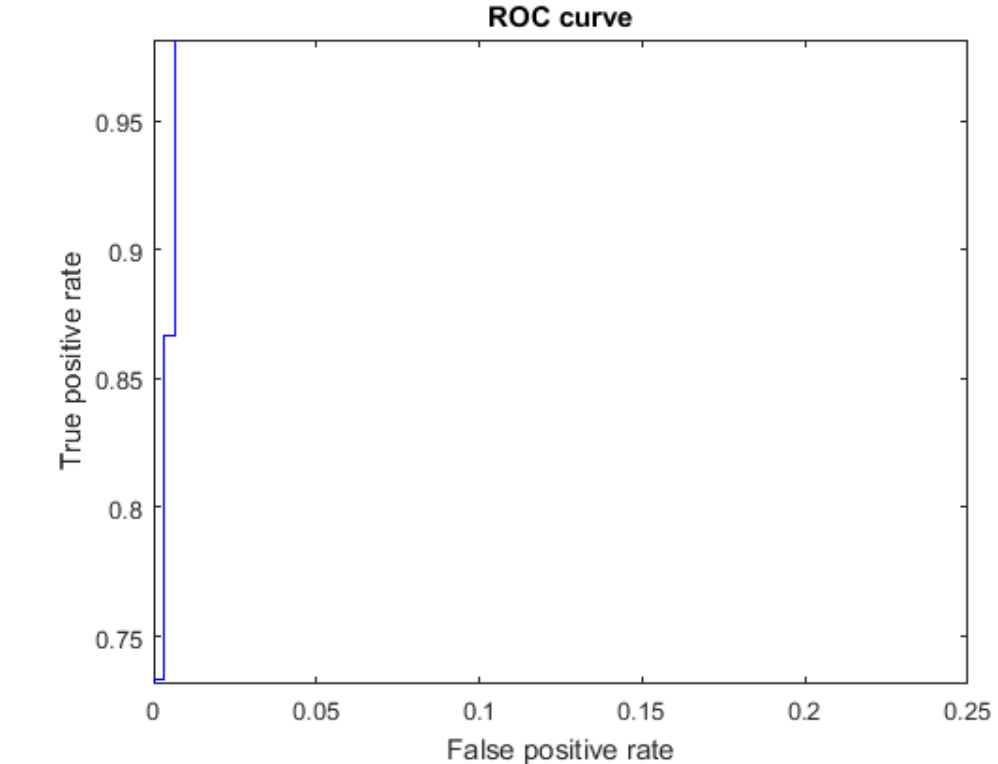
Figure 15. ROC curve for the letter P using Cartesian features, AUC = 0.9987.